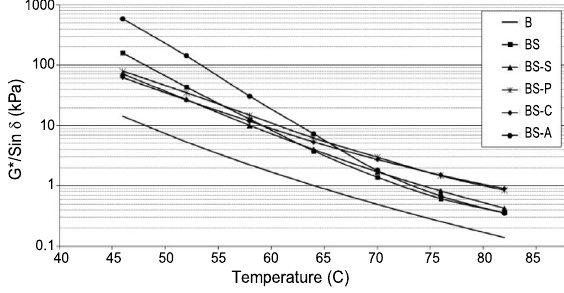
Table 9. Mixing temperature ranges of modified bitumen